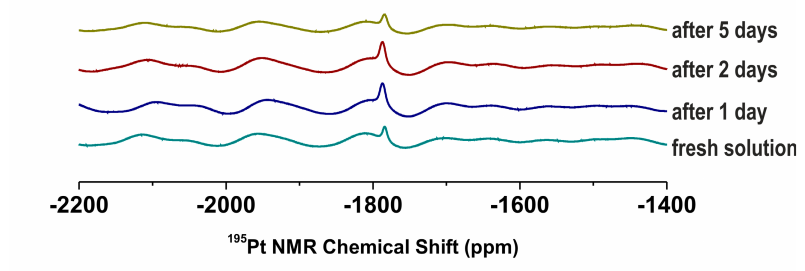
Figure 1. Time dependent 195 Pt NMR spectra on the representative complex 2 dissolved in DMF- d /H O mixture (9:1 v/v ) showing on the stability of the 7 2